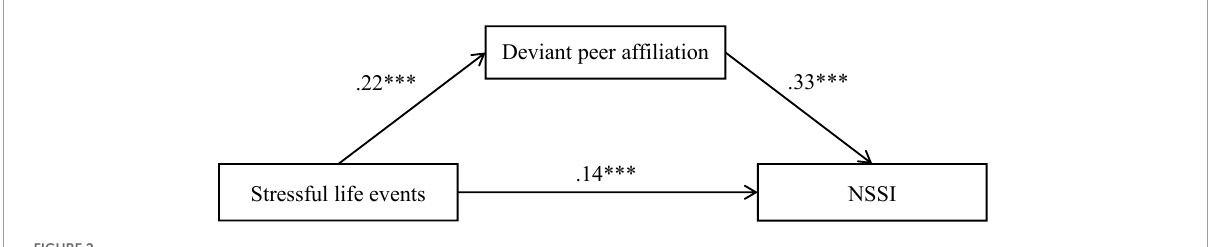
FIGURE2 Model of the mediating role of deviant peer affiliation between stressful life events and NSSI. NSSI, non-suicidal self-injury. For simplicity, the effects of demographics on deviant peer affiliation and NSSI are not displayed. ∗∗∗ p < 0.001.